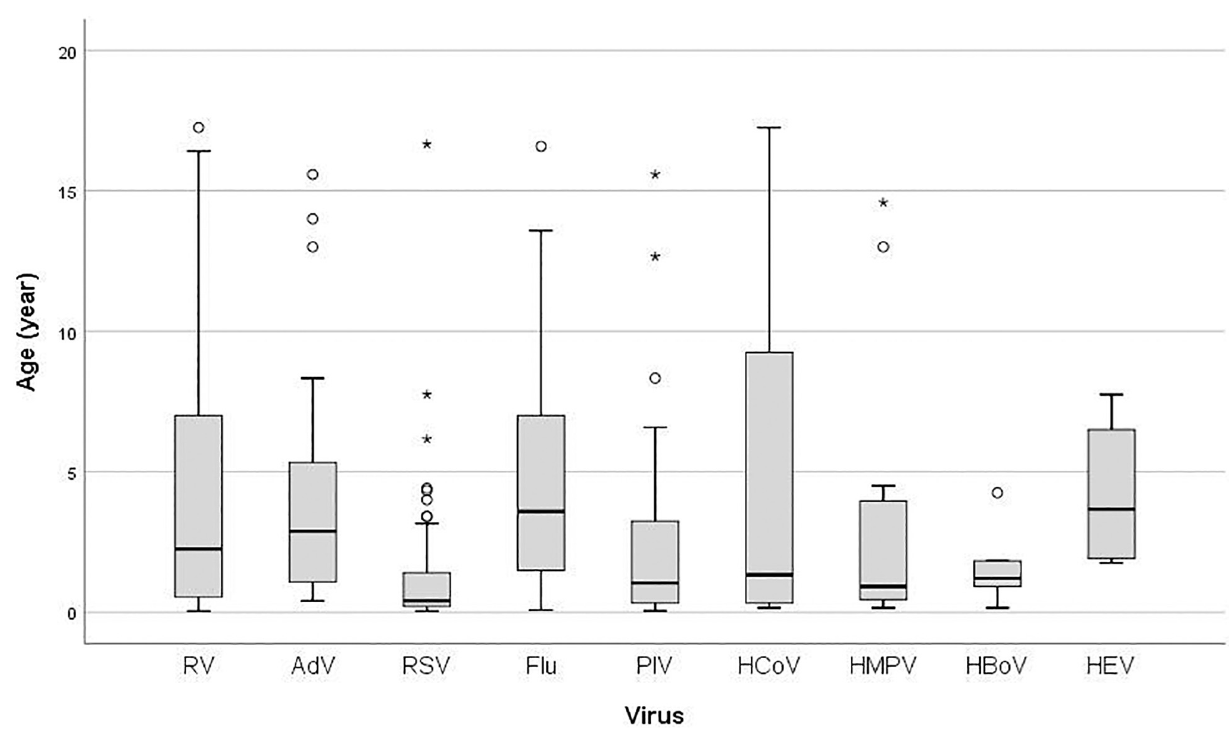
Frontiers in Microbiology |